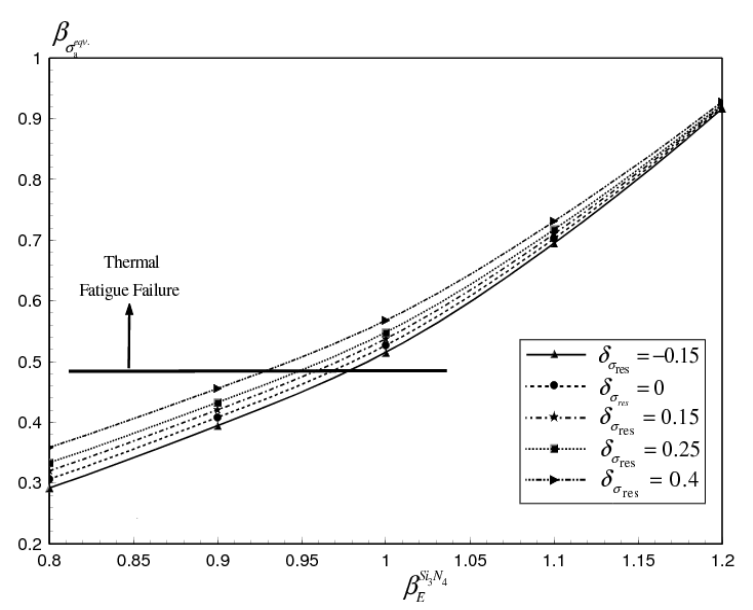
Figure 15. Effect of the variation of Young’s modulus and deposition residual stress for